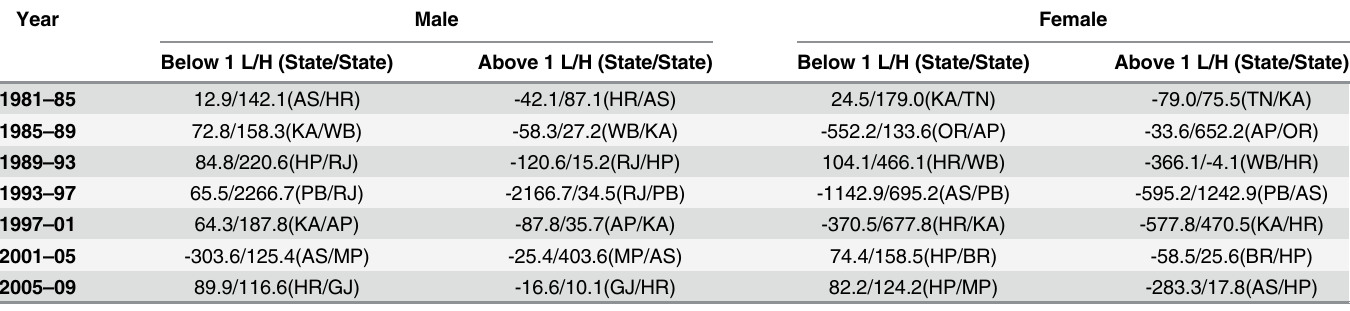
Table 4. Lower (L) and higher (H) value of the share of mortality below age one and above age one in convergence towards crossover between life expectancies at ages zero and one, 1981 –